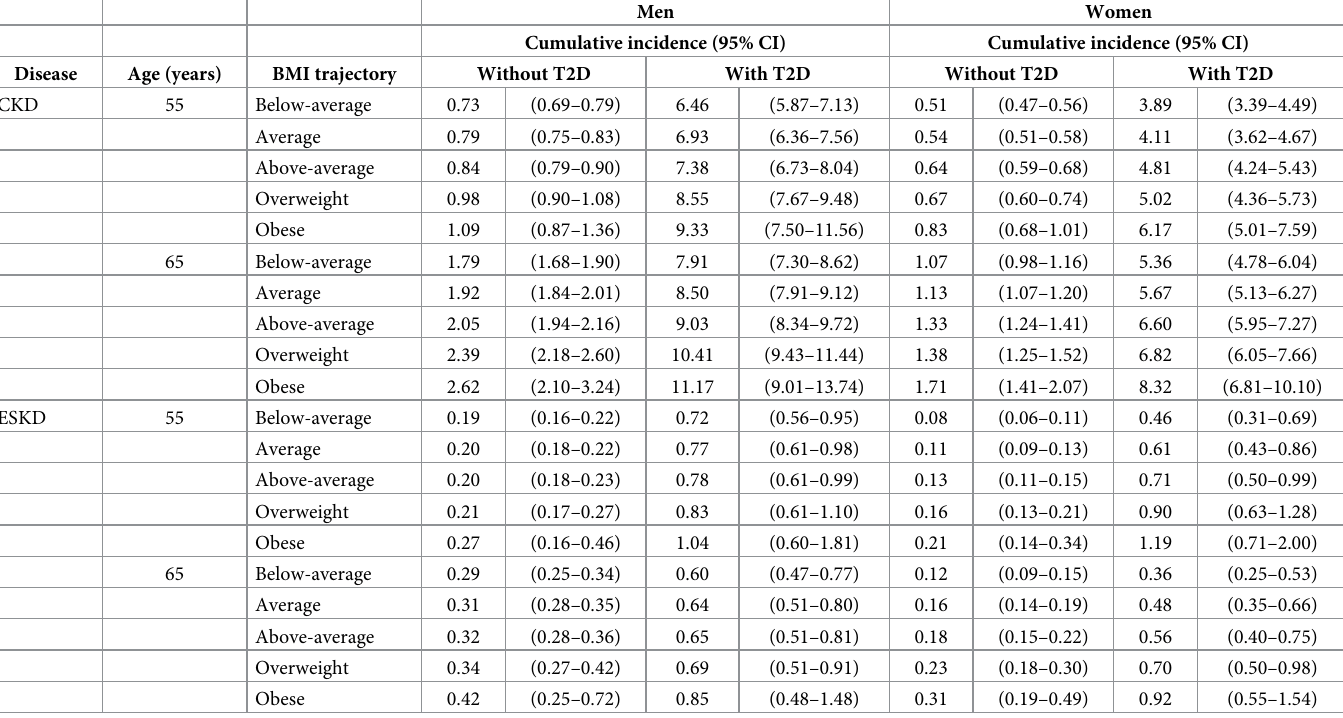
Table 2. Cumulative incidences of CKD and ESKD by childhood BMI trajectory. Sex-specific 10-year cumulative incidences (in percentages) of CKD and ESKD in individuals aged 55 and 65 years with and without T2D, respectively, by childhood BMI trajectories when taking competing risk of death into